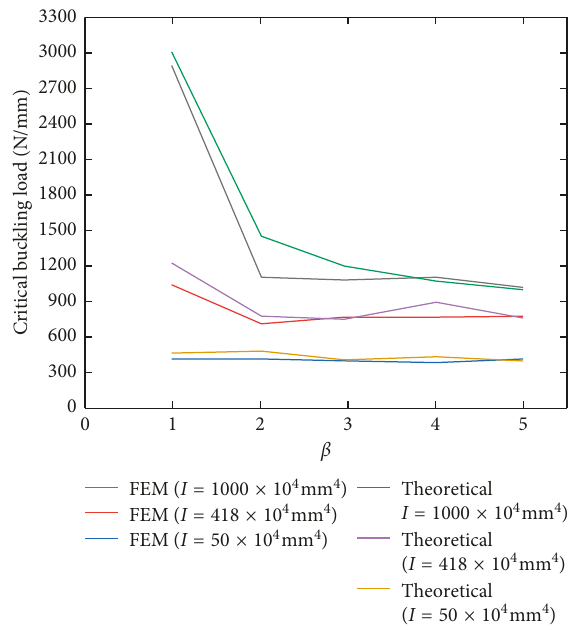
Figure 12: Comparisons between theoretical and FEM results.